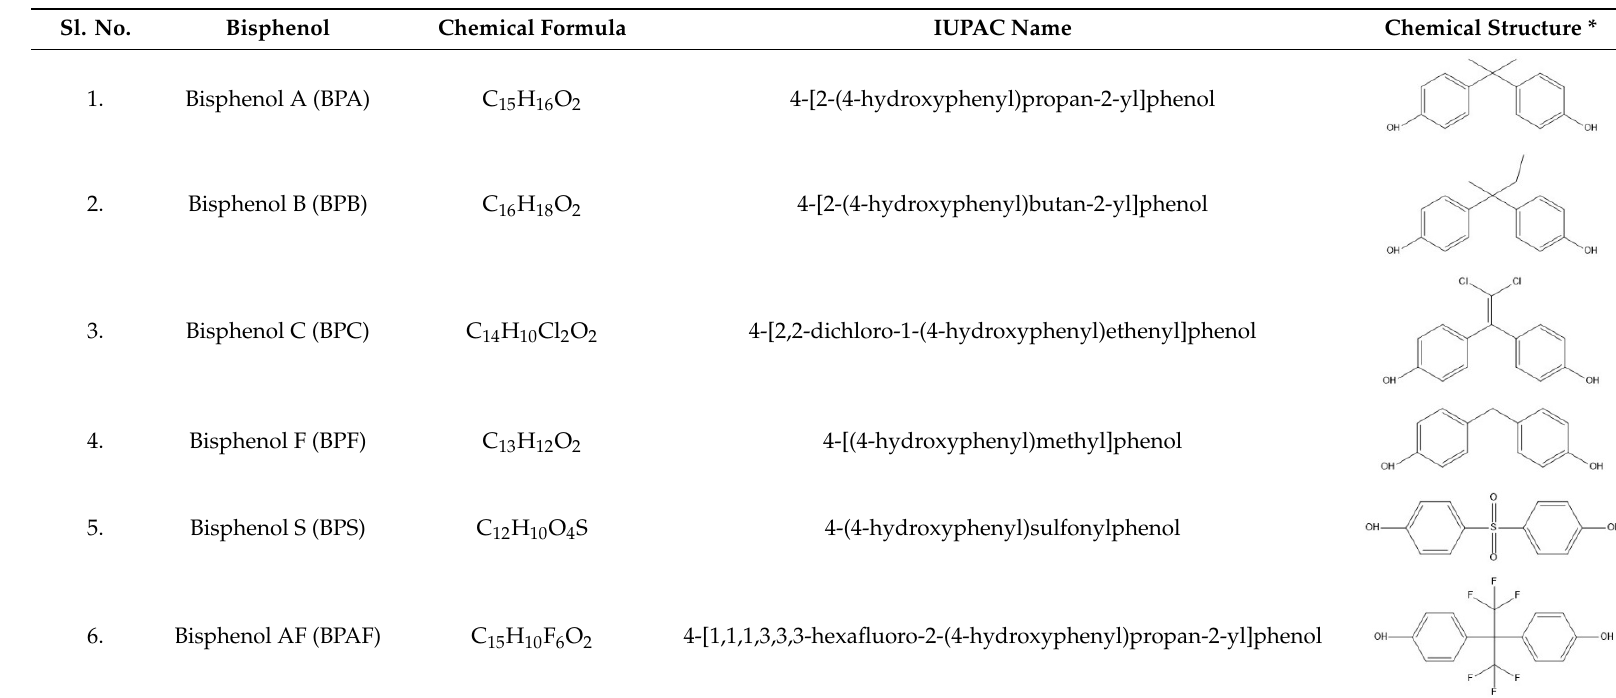
Table 1. Chemical formula, IUPAC name, and chemical structure of common bisphenols. Sl. No.